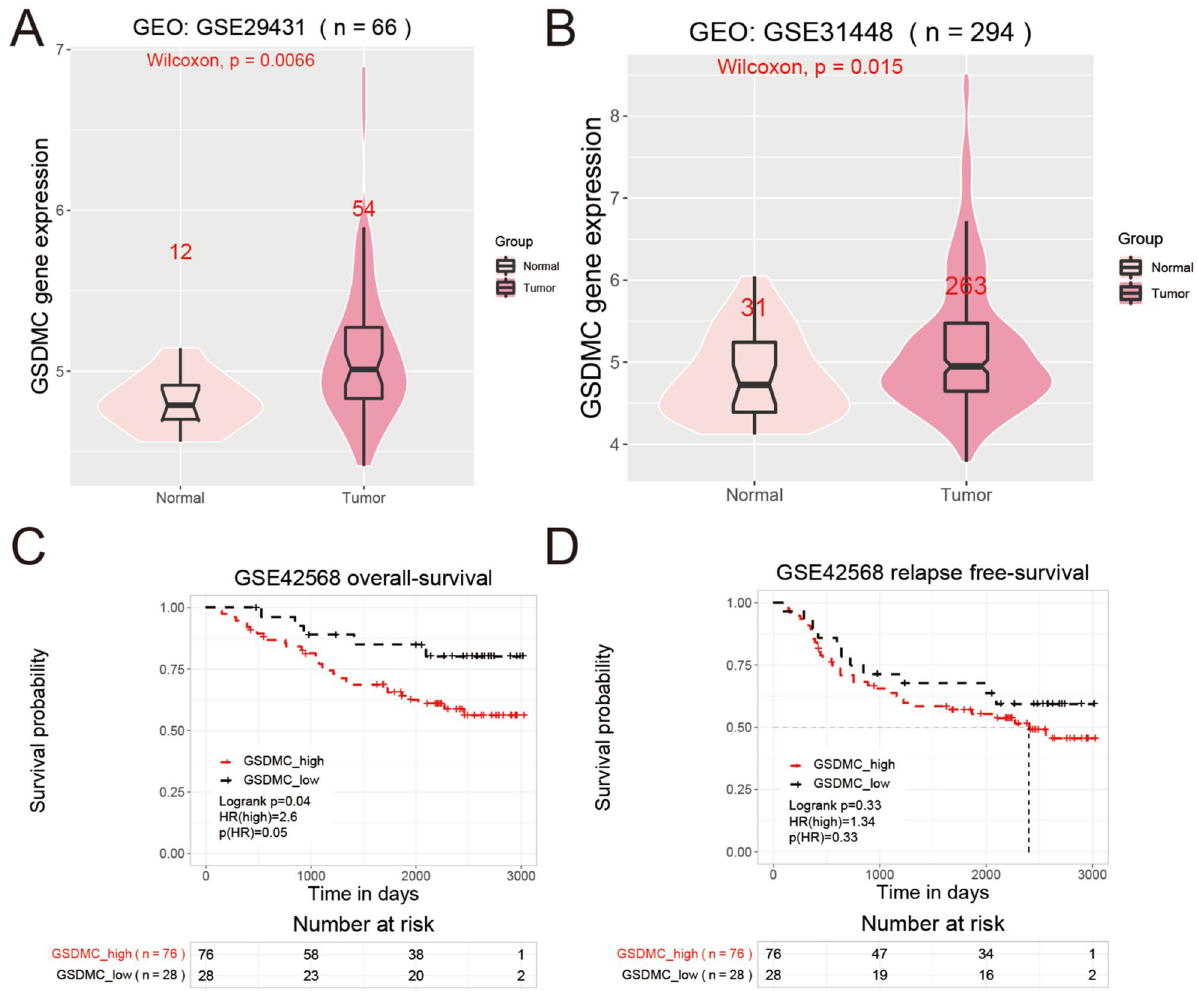
Figure 8. ( A,B ) Relative mRNA expression of GSDMC in BC and paired normal tissues from GEO database. (( A ) in GSE31192; ( B ) in GSE42568). ( C,D ) Kaplan–Meier survival curves comparing the high and low expression of GSDMC in BC from GEO database (in